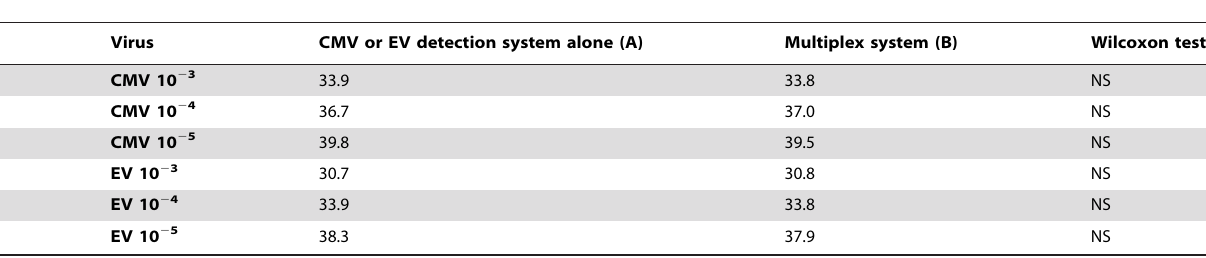
Table 3. Influence of spiking on the performance of viral nucleic acid detection.